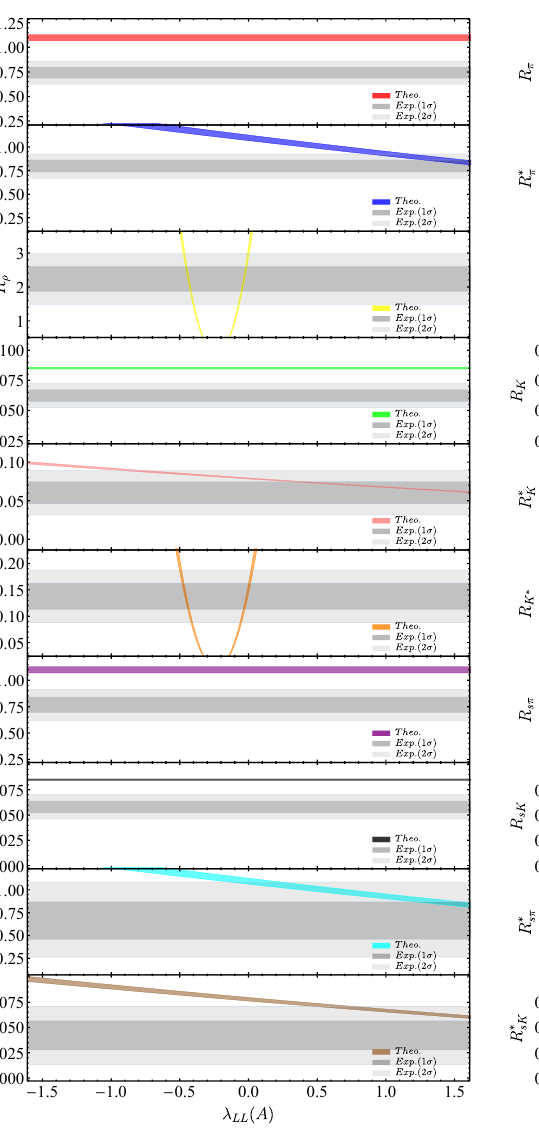
Figure 17 . Constraints on the effective coefficient λ LL ( A ) from the ratios R ( ∗ ) in the scenarios where the left- and right-handed reduced couplings are symmetric (scenario II, left) and asymmetric (scenario III, right), defined respectively by eqs. (3.13) and (3.14). The other captions are the same as in figure